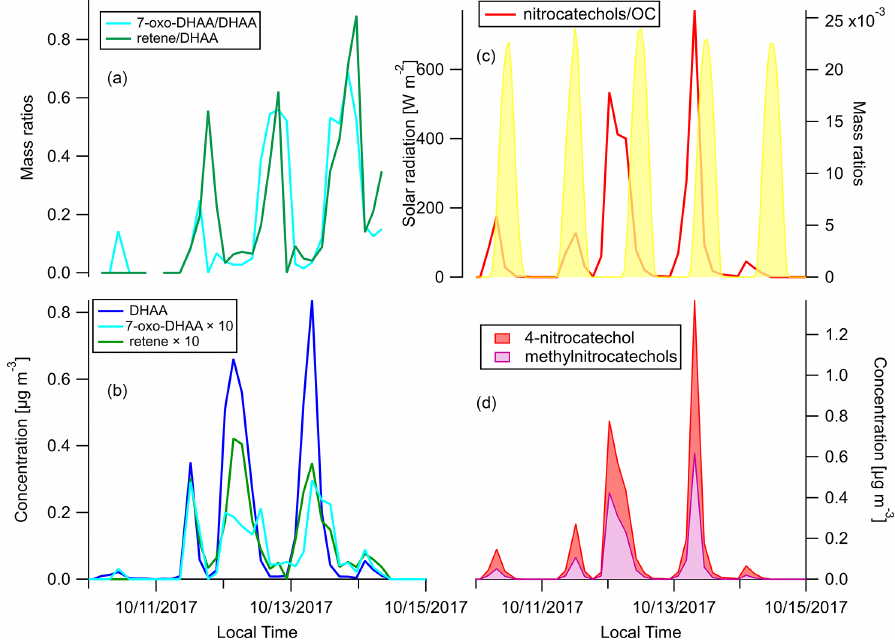
Figure 6. Time series of (a) mass ratios of 7-oxo-DHAA / DHAA and retene / DHAA, (b) concentrations of DHAA, 7-oxo-DHAA, and retene (c) , mass ratios of the sum of nitrocatechols / OC and solar radiation, and (d) concentrations of 4-nitrocatechols and methylnitrocate- chols. Solar radiation in panel (c) was measured at Bethel Island, a measurement site in between Napa and Berkeley.